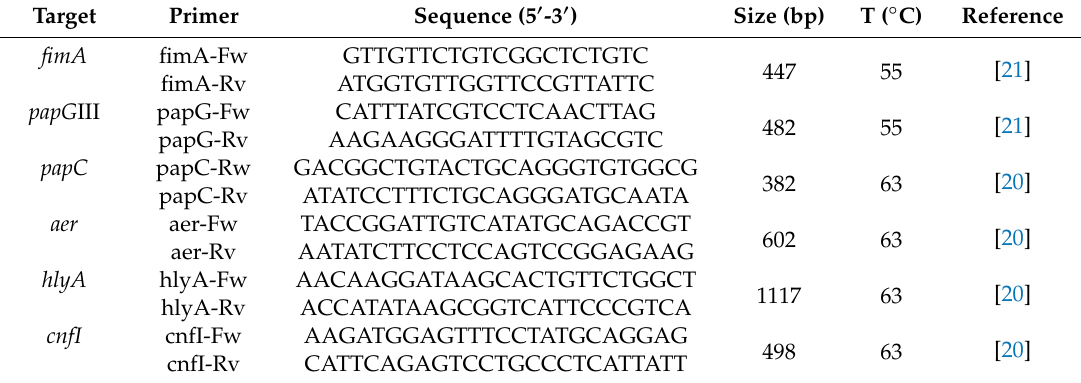
Table 1. Primers and conditions used for the amplification of virulence factors